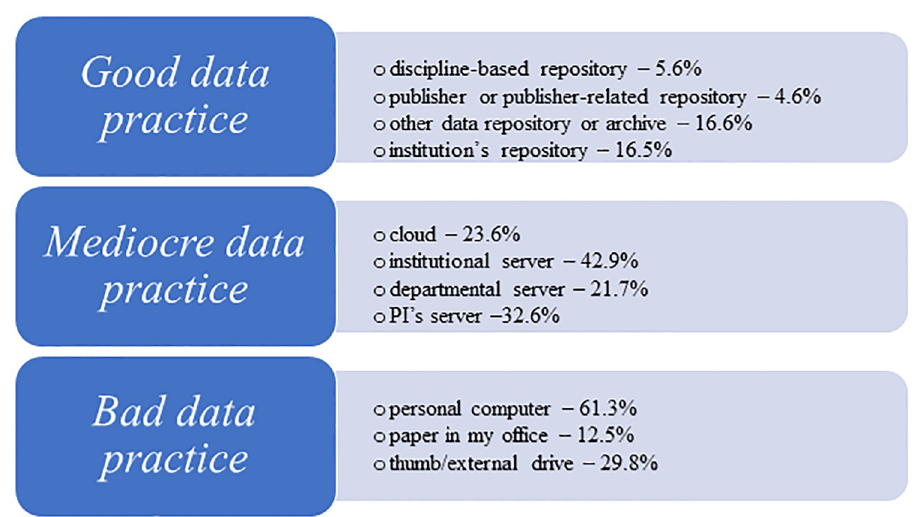
Fig 5. How much of your data do you currently store or deposit in the following locations? (The number is a sum of answers “Most data” and “All data.”).